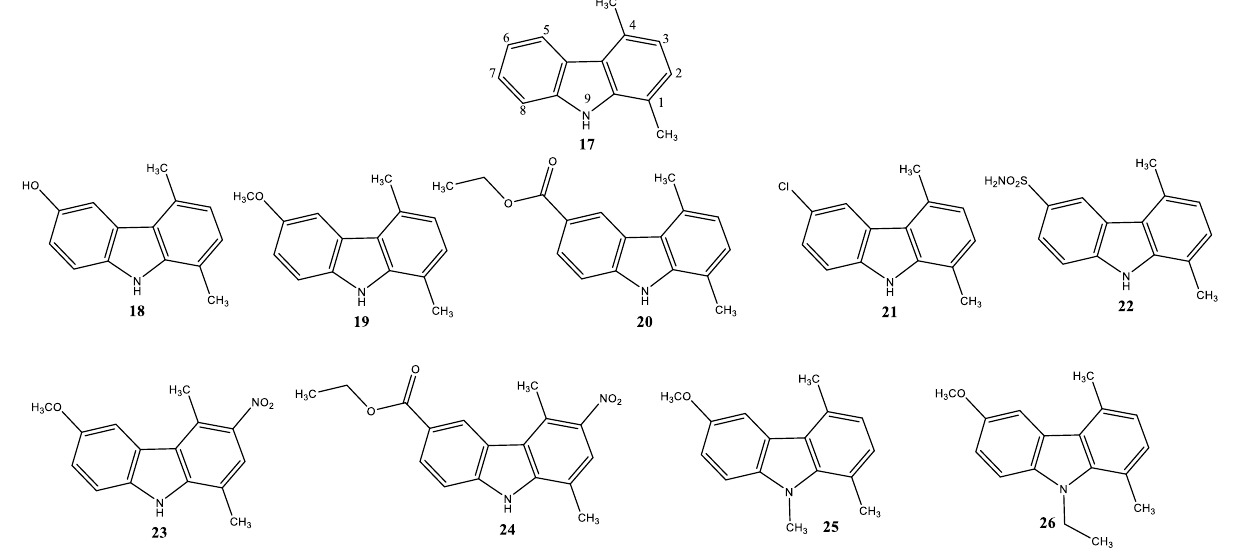
Figure 12. 1,4-Dimethyl-carbazole derivatives ( 17 – 26 ).